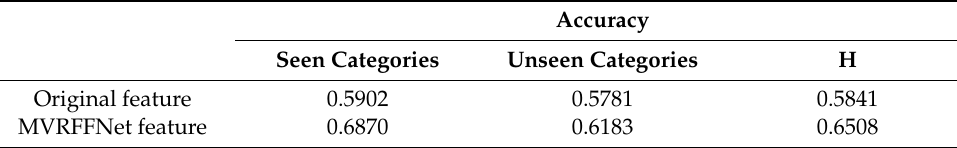
Table 7. Matching accuracy on the test set of the fine-grained recognition dataset.